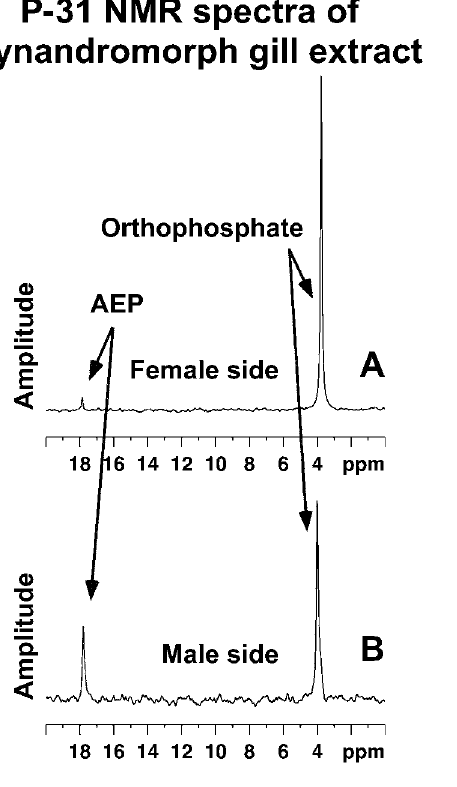
Figure 6. P-31 NMR spectra of aqueous extracts from the gynandromorph female and male side gills. The rare gynandromorph blue crab offered a unique opportunity to compare male and female gills from a single crab. Any differences between male and female side gills are caused by inherent biochemical differences between the sexes not a difference in the crab’s diet or habitat. P-31 NMR spectra were obtained from aqueous extracts from male and female side gills, lyphilized to dryness then dissolved in a dilute solution of trisodiium ethylenediaminetetraacetate in deuterium oxide. Only two P-31 NMR signals were seen in each extract, orthophosphate and AEP. AEP on the female side A represented only 3% of the phosphorus signals. The male side gill B had 21% of its phosphorus signals in AEP. Because AEP is normally found distributed throughout the male’s tissues, it was not surprising that some AEP had been incorporated into the female gill.